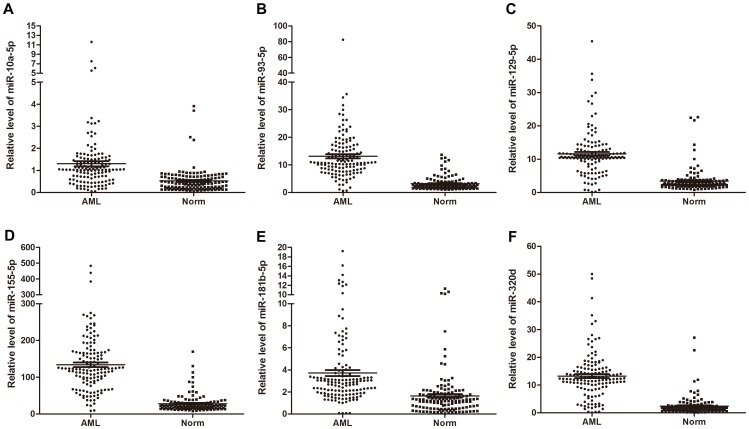
The relative levels of 6 serum miRNAs in 140 AML patients and 135 healthy control individuals (in both the training and validation sets) determined using a qRT-PCR assay.Each point represents the mean results for triplicate samples.